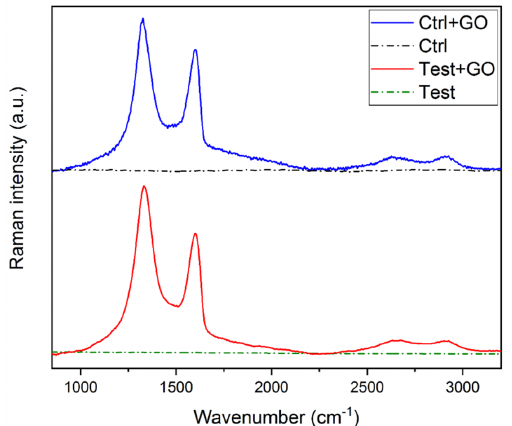
Figure 1. Raman spectra of control + GO (blue line), control (black dash dotted line), test + GO (red line), and test (green dash dotted line). Control + GO and test + GO spectra are normalized with respect to the G band.